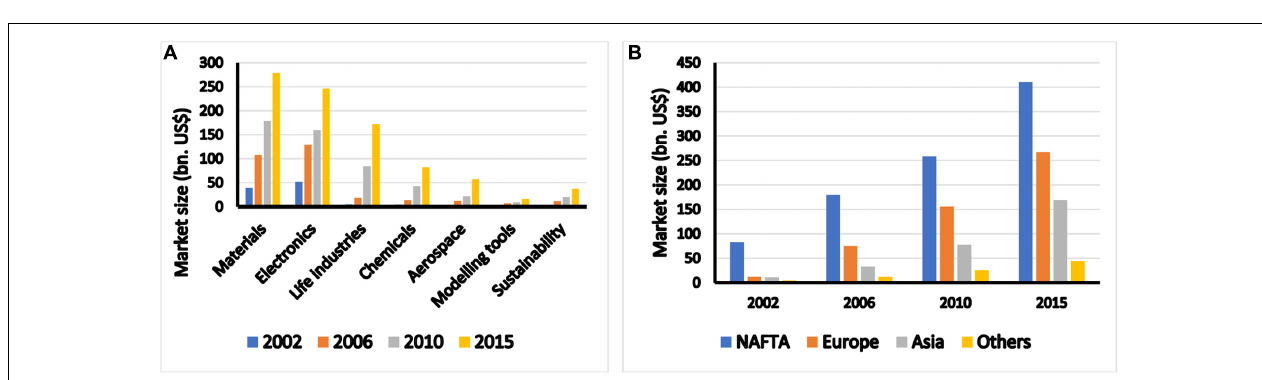
FIGURE 2 | World market of nanotechnology by applications (A) and regions (B) . Source of data: Helmut Kaiser Consultancy (hkc22.com), Accessed date: March 15, 2017.